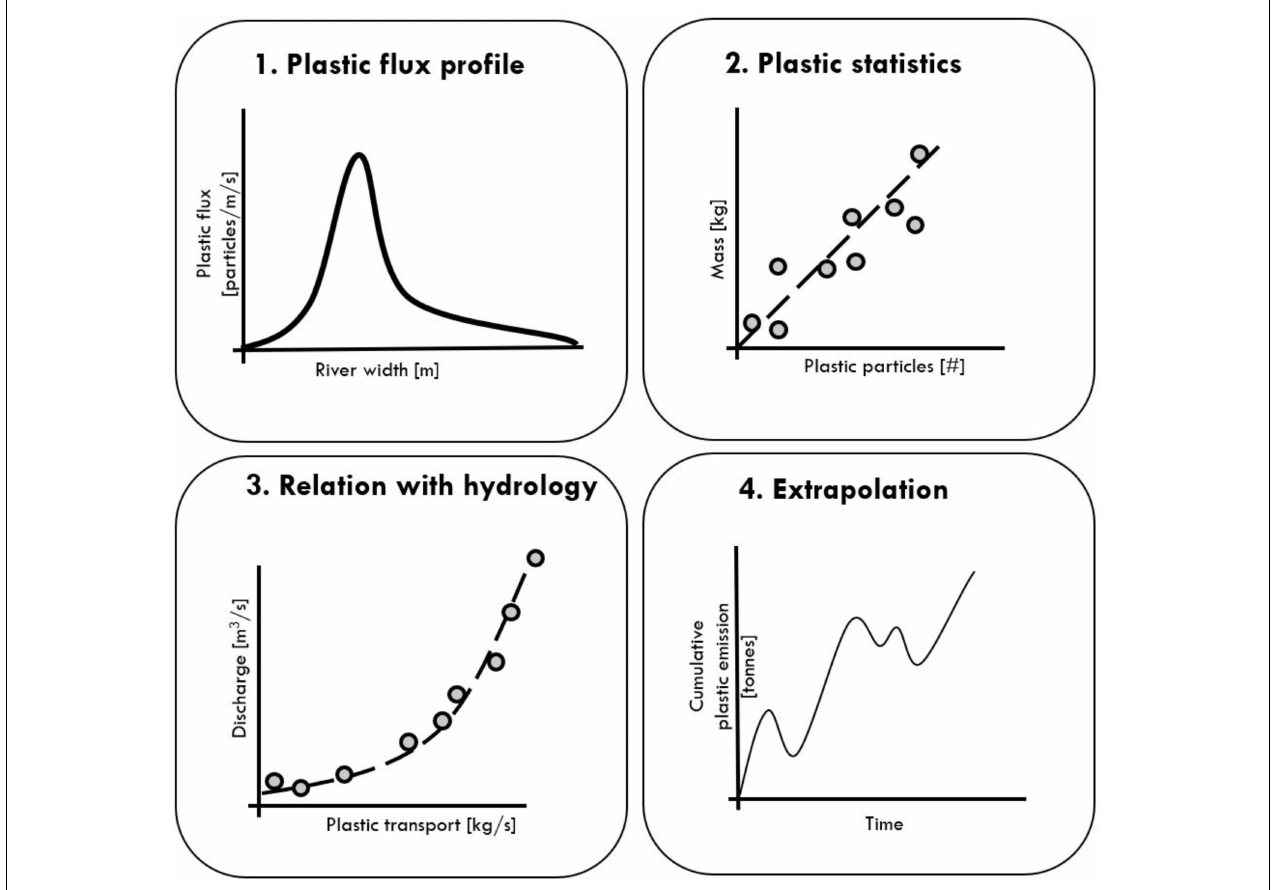
FIGURE 1 | Proposed step-wise methodology to characterize macroplastic dynamics from rivers into the